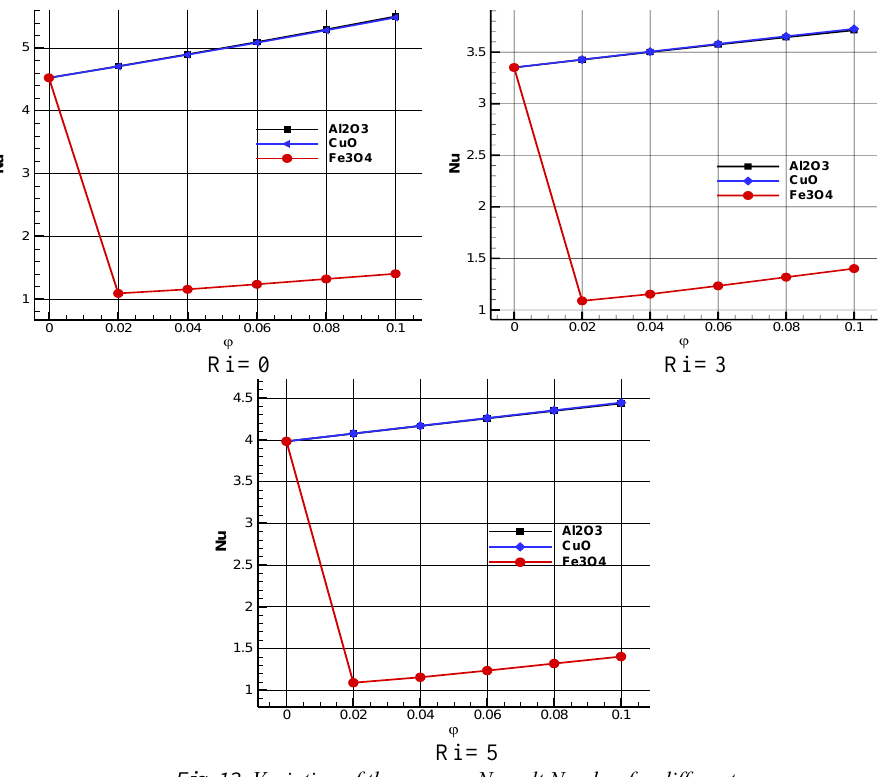
Fig. 13. Variation of the average Nusselt Number for different φ, with Ha = 25 an Ri = 0, 3,